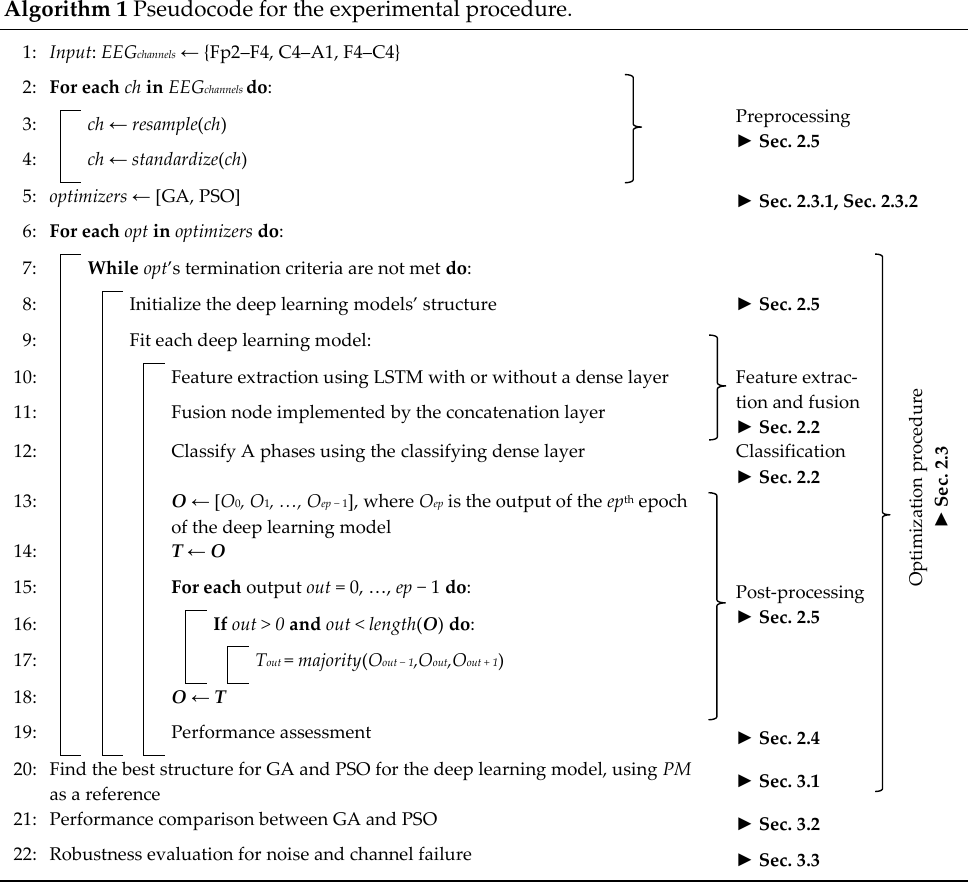
Table 1. The average total sleep time of the studied population was 27,761.25 s, ranging from 22,230.00 to 33,210.00 s, with a standard deviation of 3197.07 s. The number of one-second epochs related to an A phase was